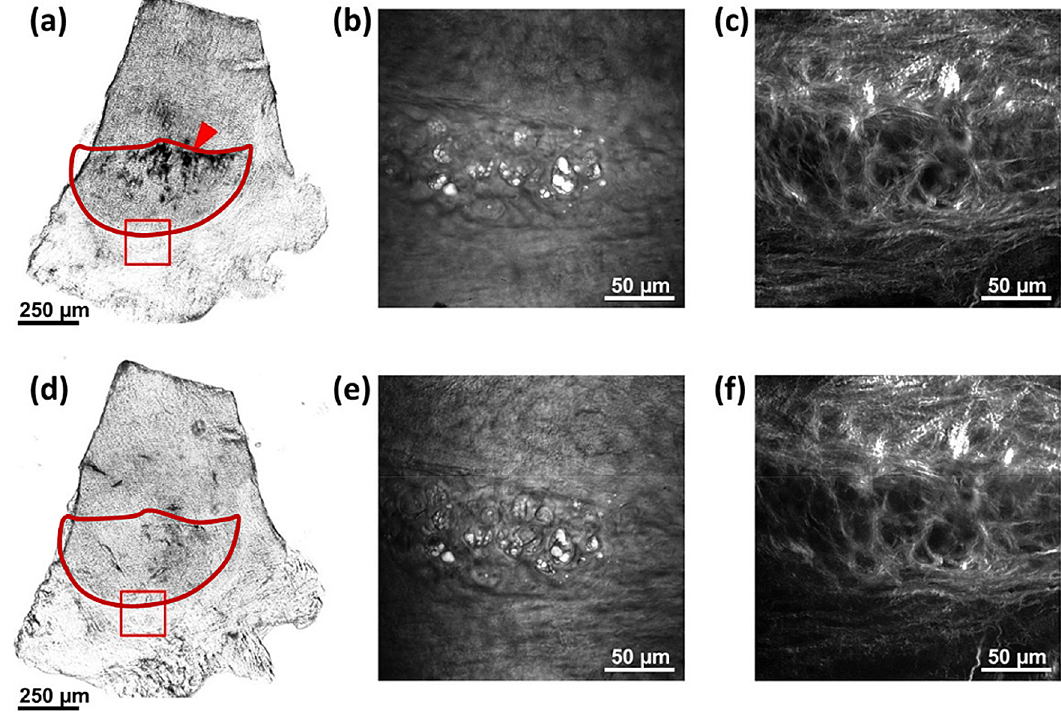
Figure 2. Images of a leaflet before and after melanin bleaching in 2.5% H 2 O 2 solution. ( a ) Bright field image of the whole leaflet (red contour) before bleaching showing visible accumulations of melanin (red arrowhead). ( b ) CARS image of the region of the annulus in the red box in ( a ) acquired before bleaching with the adipocytes clearly identified by the intense CARS signal of the lipid droplets. ( c ) SHG image of the region in the red box in ( a ) acquired before bleaching showing the dense mesh of collagen fibers. ( d ) Bright field image of the whole leaflet (red contour) after bleaching without any visible melanin. ( e ) CARS image of the region in the red box in ( d ) acquired after bleaching with the adipocytes clearly identified by the intense CARS signal of the lipid droplets. ( f ) SHG image of the region in the red box in (d) showing no alterations of the mesh of collagen fibers after